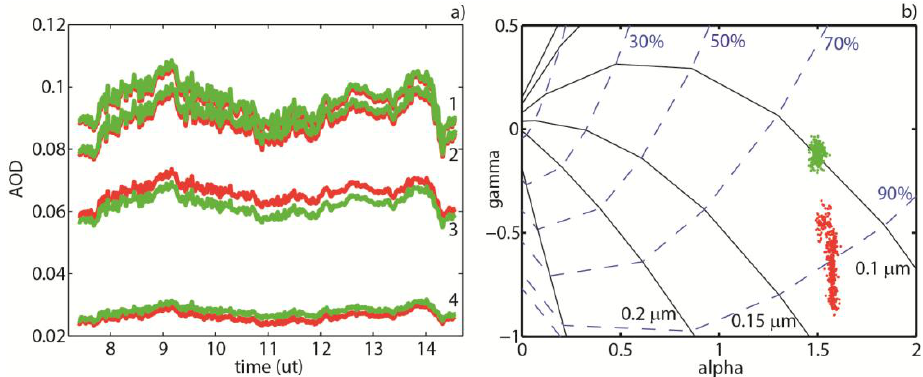
Fig. 3. (a) SPM data of 10 November 2011 used for improving the calibration by minimizing the TDV amplitude with a MC method. The difference of retrieved AOD with V C (red) and the new V best (green) is within the measurement uncertainty. (b) The effect of the improved 0 0 calibration on the AGa-plot is significant. Notably, the green points are more clustered and shifted to a larger γ value. The grid lines refer to fine mode radius (µm) and fraction